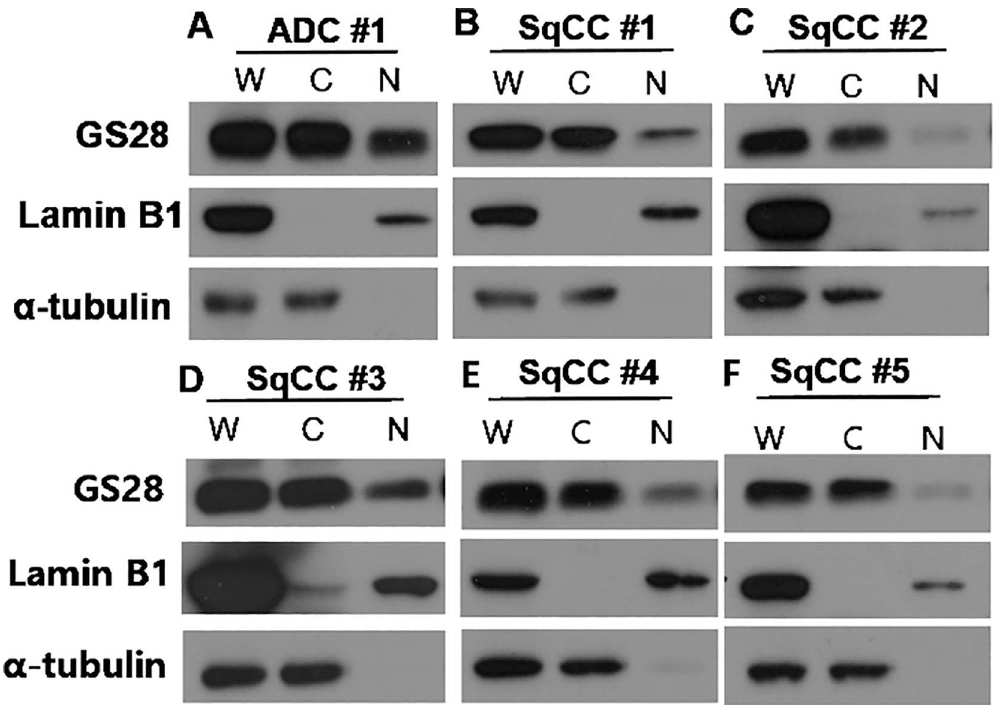
Fig 3. Immunoblottingof cervicalcancertissueextracts. Whole (W),cytoplasmic (C),and nuclear (N) fractions were preparedfromtissues of one adenocarcinoma(ADC)and five squamouscell carcinomas(SqCC),and GS28 expression in the fractionswas examined by immunoblotting using the anti-GS28antibody. LamininB1 and α - tubulin were used as the nuclear and